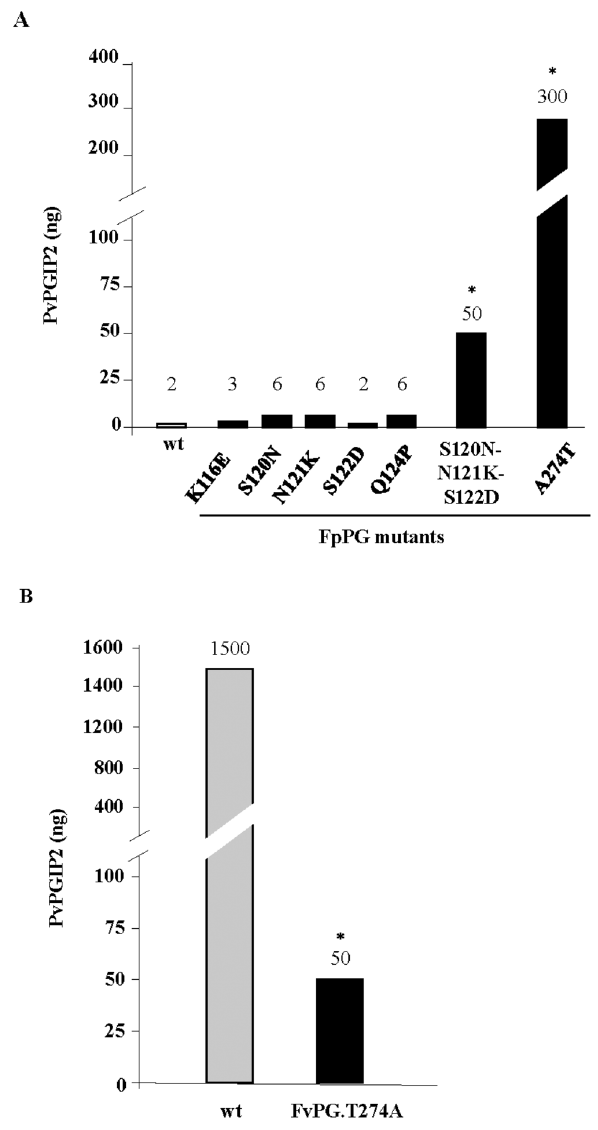
Figure 5. Inhibitory activities of PvPGIP2 against wild type (wt) and mutated forms of FpPG (A) and FvPG (B). The amount of PvPGIP2 (ng) causing 50% inhibition of one agarose diffusion unit of the indicated PGs at pH 4.7 are shown. Asterisks indicate statistically significant differences with wt PGs, according to Student's t test (*, P < 0.003).